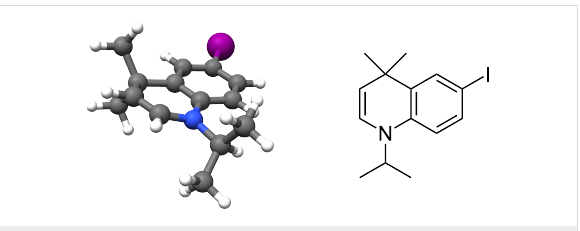
Figure 2: Simulated structure of 22 indicates a flattened quinoline-like structure. Hartree–Fock calculations (3-21G*) were conducted using Spartan’10, and visualised using UCSF Chimera 1.11